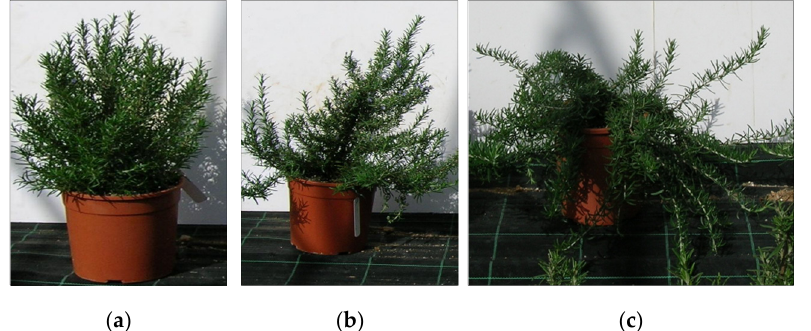
Figure 1. Types of plant habitus of rosemary biotypes in the study. ( a ) refers to erect habitus, ( b ) refers to semi-erect habitus, ( c ) refers to prostate